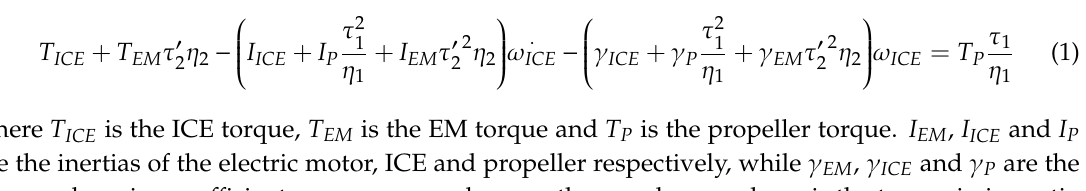
Figure 2. Functional scheme of the real test bench for the parallel hybrid propulsion architecture under analysis.